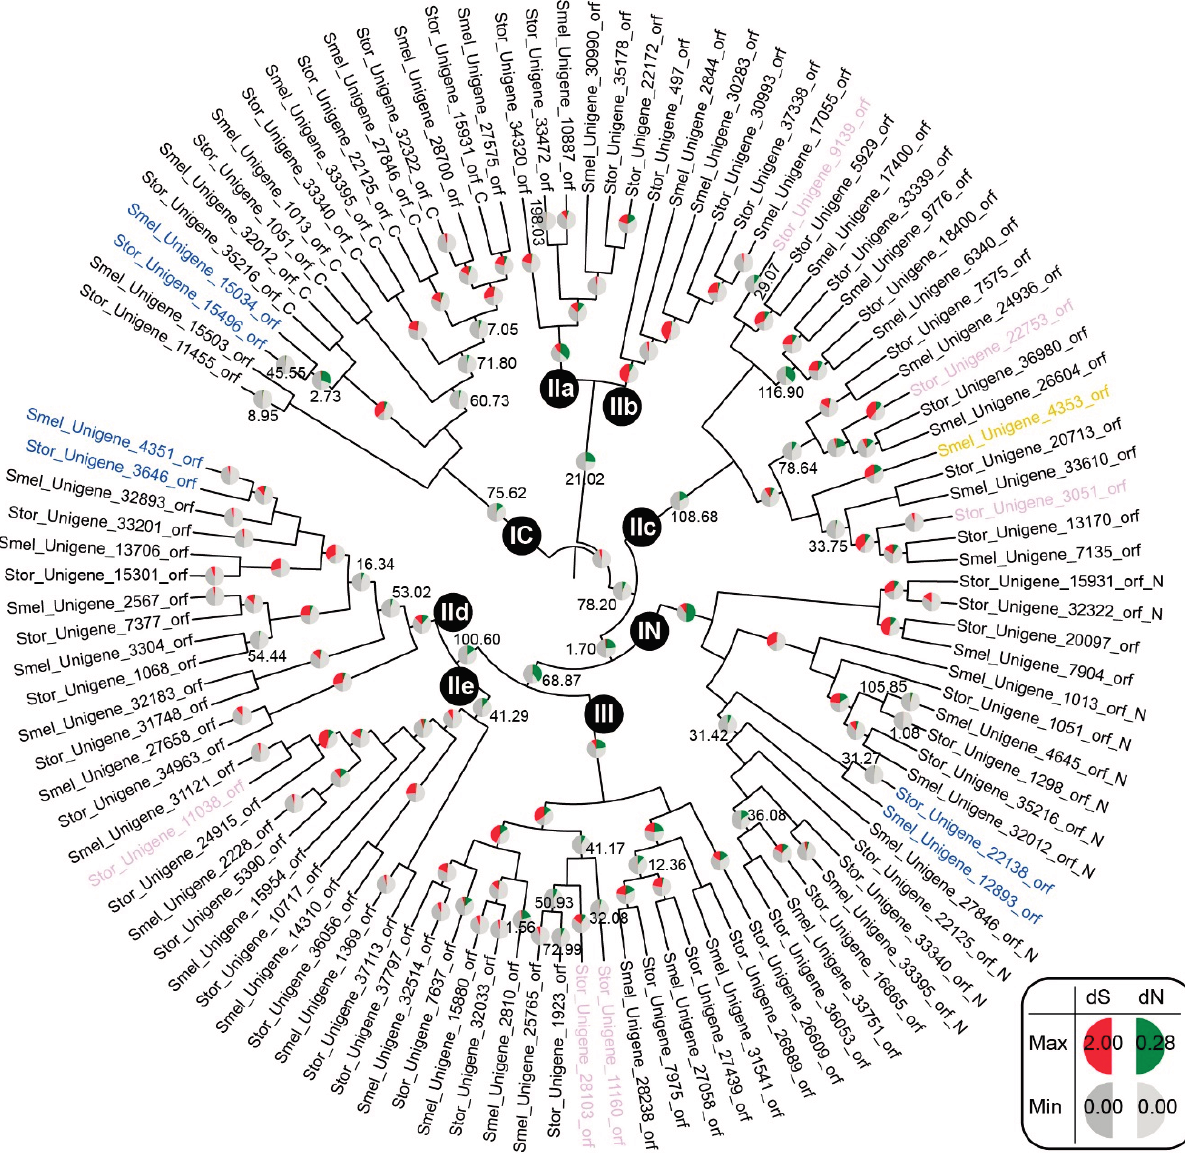
Figure 3. The branch-specific d N, d S and ω ratios of SmelWRKYs and StorWRKYs. The WRKY groups and subgroups are indicated. Branch-specific d S and d N are given if the d S value of that branch is between 0.1 and two or the ω ratio of that branch is >1. The left half of the circular inserts at each branch designates the branch-specific d S, and the size of the red sector is in proportion to d S, which ranged from zero to 2.00. The right half designates the branch-specific d N, and the size of the green sector is in proportion to d N, which ranged from zero to 0.28. The number on a branch is the ω ratio of that branch (only ω ratios >1 are given). Tips labeled with color are genes in some special orthologous groups identified by OrthoMCL (Table S2). Blue, eggplant- and turkey berry-specific orthologous groups; light purple, orthologous groups with genes from turkey berry, but without genes from eggplant; orange, orthologous groups with genes from eggplant, but without genes from turkey berry (Table